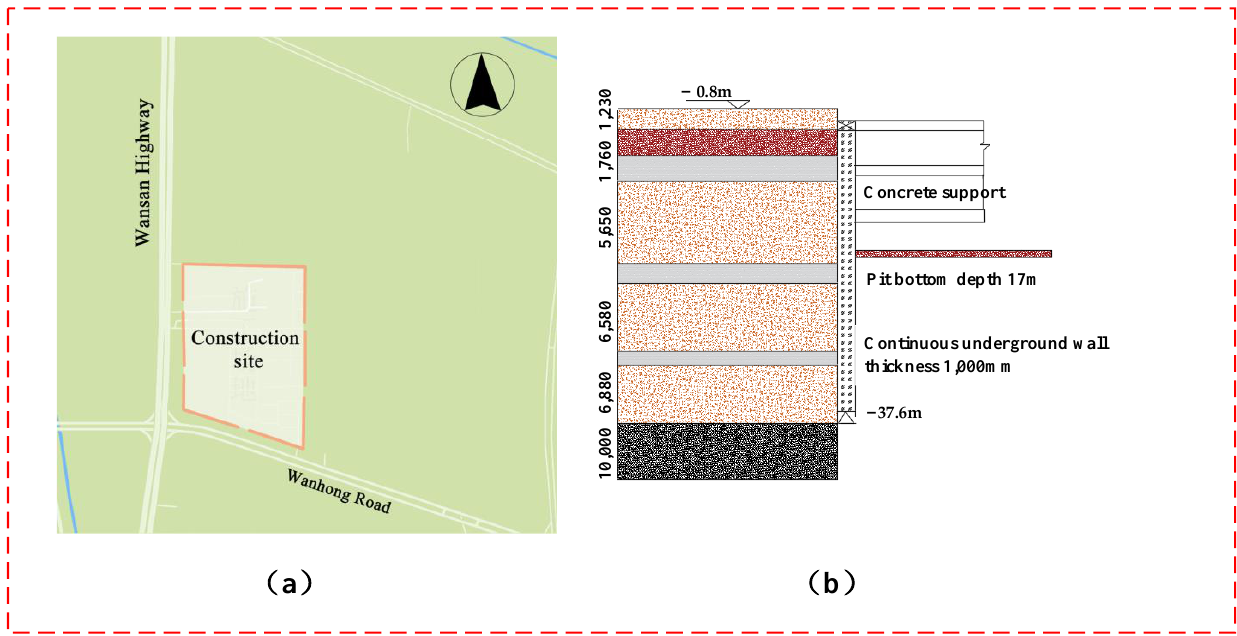
Figure 2. Engineering and geology overview: ( a ) construction site map; ( b ) stratigraphic map.